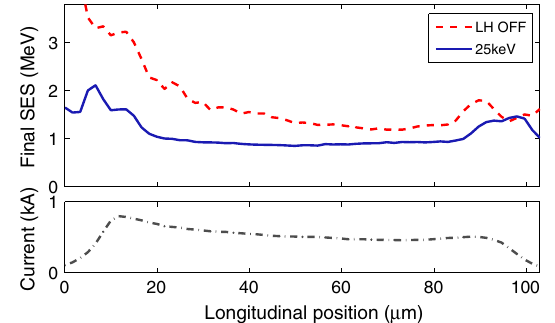
FIG. 10. A 30-shot average of SES as a function of position along the bunch for the laser heater off (dashed red line) and with induced energy spread at the heater of 25 keV (solid blue line). Bottom plot shows current as a function of position along the bunch, with approximately 0.5 kA at the core.